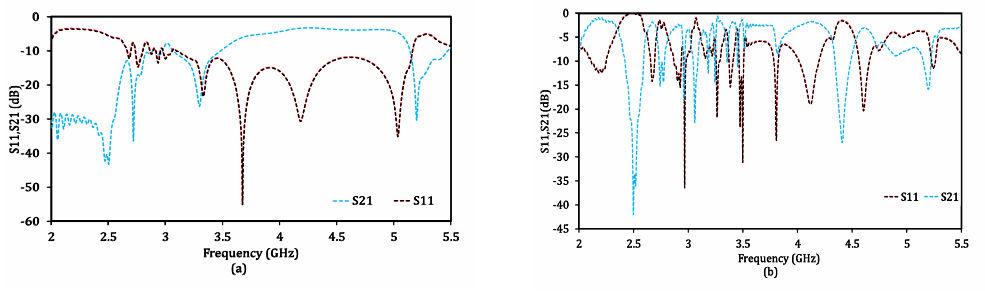
Figure 5. Reflection and transmission coefficients of 5 × 5 EBG array. ( a ) Mushroom-like EBG unit; ( b ) EBG with plus-shaped